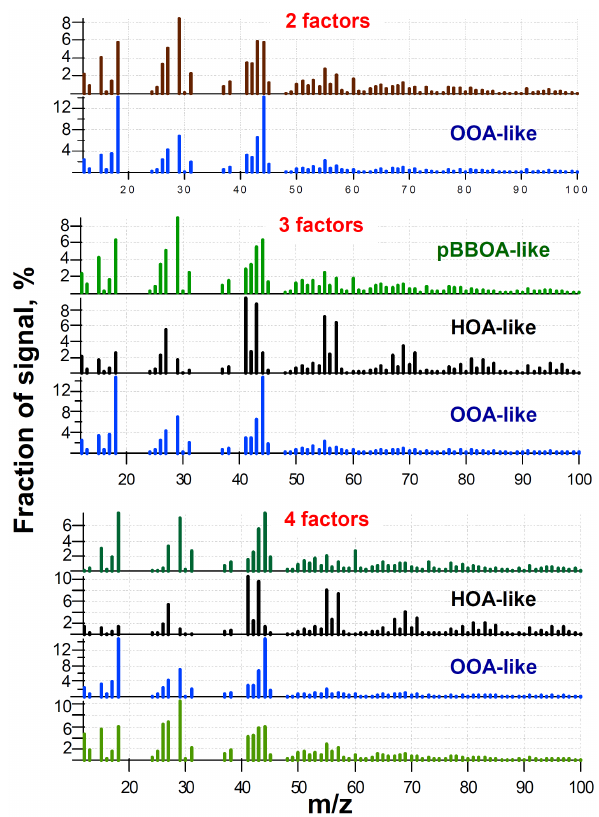
Figure 5 Fig. 5. Spectra of all PMF factors calculated by 2-, 3- and 4- factorial PMF (PMF analysis for the 18–29 January period, with “FPEAK” = − 0.2 and “seed” =